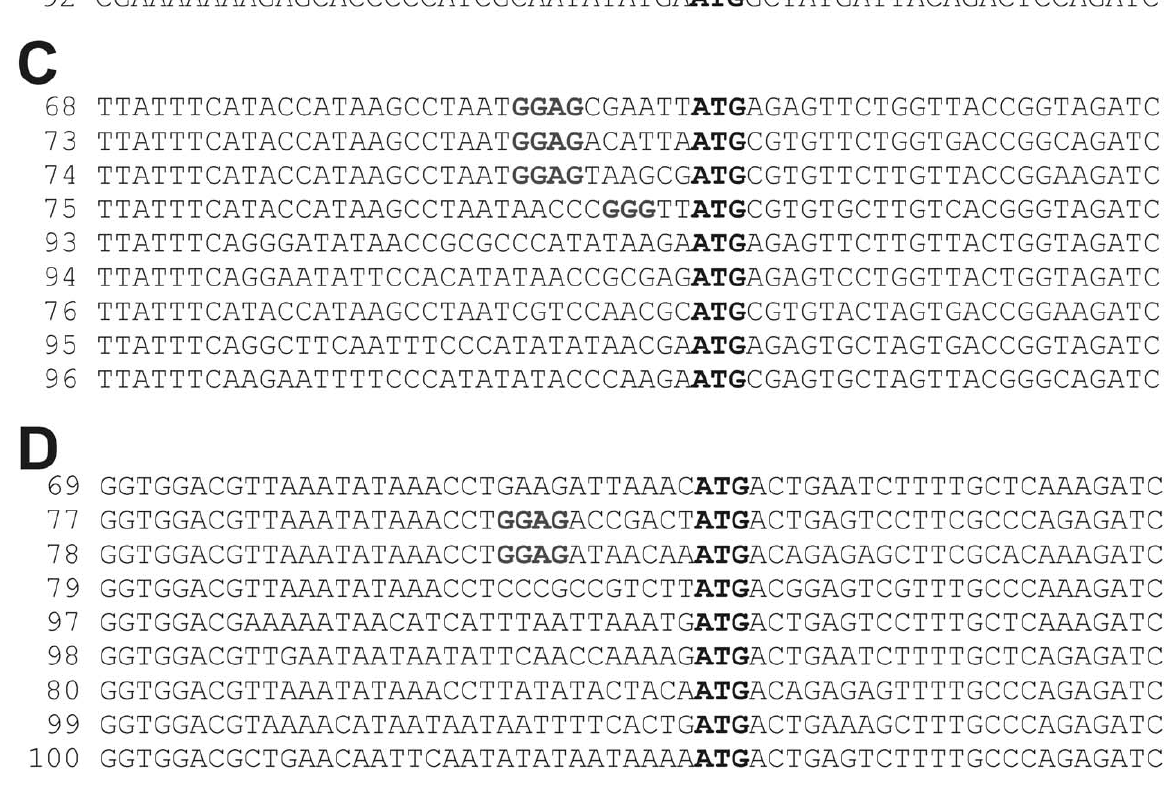
Figure 3. Reporter gene constructs. (A) Schematic map of the lacZ’ cassette. Promoter ( Prrn ), 3 9 UTR ( rps16 3 9 UTR) and coding region ( lacZ’ ) are marked. The arrow denotes the direction of transcription. The sequence between the BamHI and BglII restriction sites was exchanged in the various constructs (i. e., the 5 9 UTR indicated by the cross-hatched box and the first 21 nt of the coding region indicated by the open box). (B) Sequences from -33 to + 26 of the constructs based on the gene 10 5 9 UTR and the 5 9 end of the lacZ ’ coding region. The numbers indicate the pLS plasmid numbers. pLS67 contains the unmutated sequence. (C) Sequences from -33 to + 26 of the constructs based on the galE 5 9 UTR and 5 9 end of the coding region. pLS68 harbors the wild-type sequence. (D) Sequences from -33 to + 26 of the constructs based on the rpsA 5 9 UTR and 5 9 end of the coding region. pLS69 contains the wild-type sequence. Shine-Dalgarno sequences are shown in bold grey letters, the ATG start codon is indicated by bold black letters.